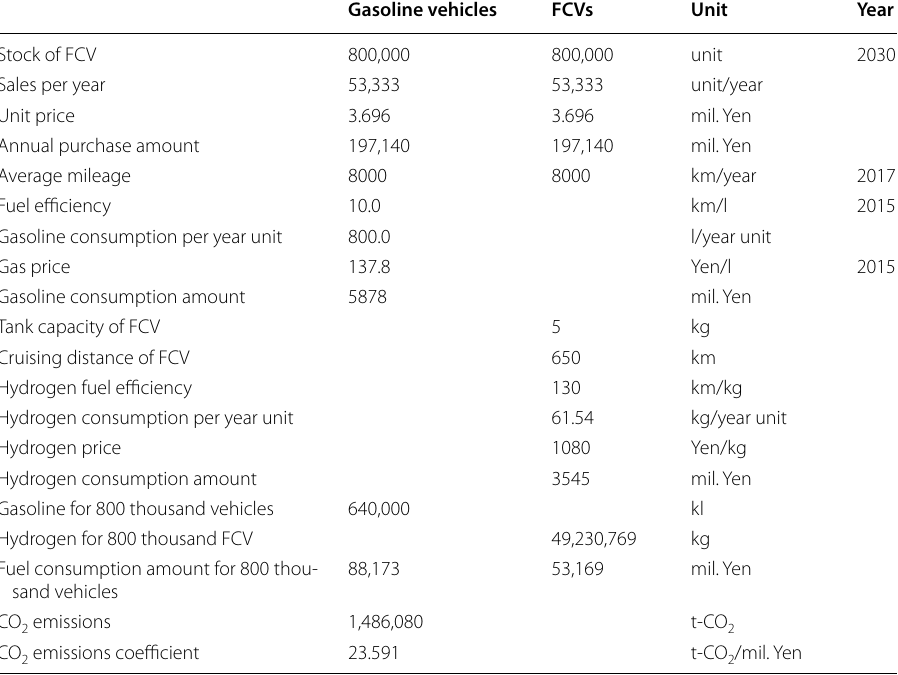
Table 7 Comparison of gasoline vehicles and FCVs. Source : Authors’ calculation Gasoline vehicles